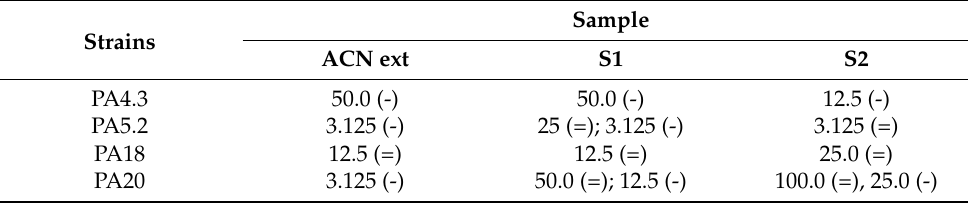
Table 3. Result of antibacterial assays for the ACN extract and compounds Sydowinol (S1) and Sydowinin A (S2) of Guignardia mangiferae against strains of Xanthomonas axonopodis pv. passiflorae ( µ